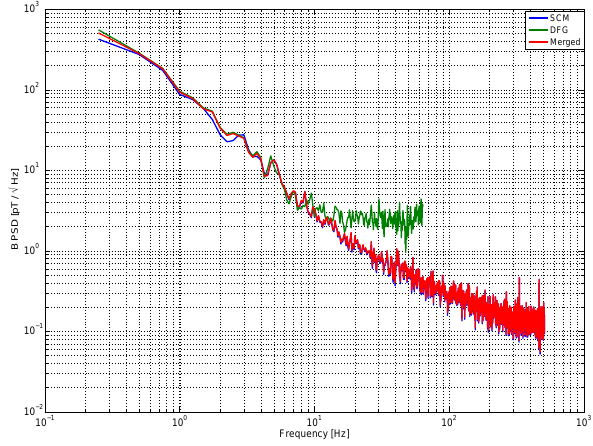
Figure 12. PSD comparison of SCM and DFG on MMS1 during a quiet field period on 20 September 2015, 06:33:31UTC.